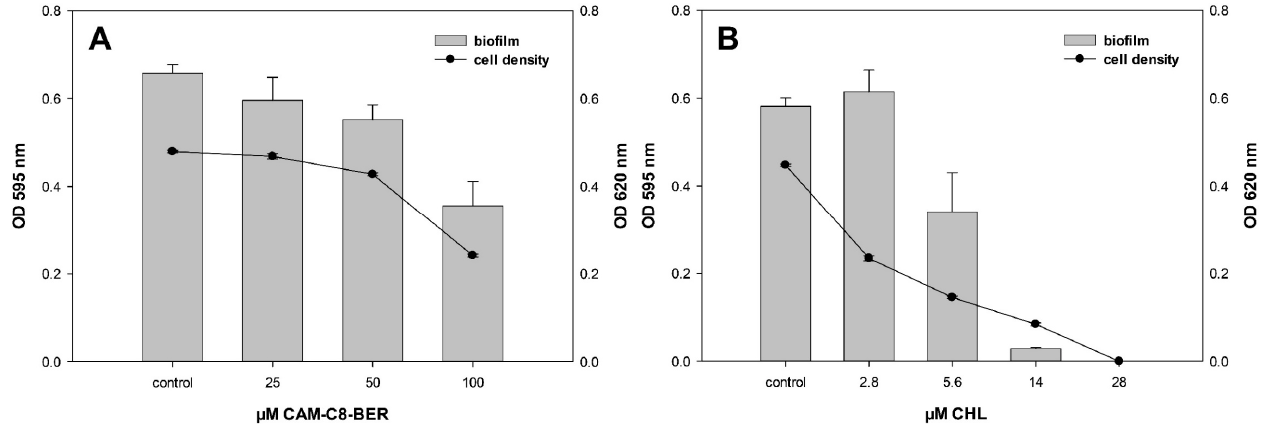
Figure 6. Biofilm formation of E. coli at different concentrations of CAM-C8-BER ( A ) and CHL ( B ). E. coli WT cells were exposed 20 h with the test compounds, and their cell density (black curves) and surface attachment (gray bars) were measured. Values for cell density (OD 620 ) are indicated on the right y-axis, and biofilm values (OD 595 ) are indicated on the left y-axis.